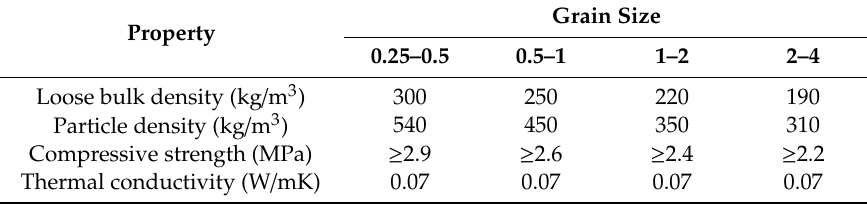
Figure 1. Expanded glass aggregate (EGA) with a different grain size. Table 1. Physical, mechanical, and thermal properties of the EGA (Expanded Glass